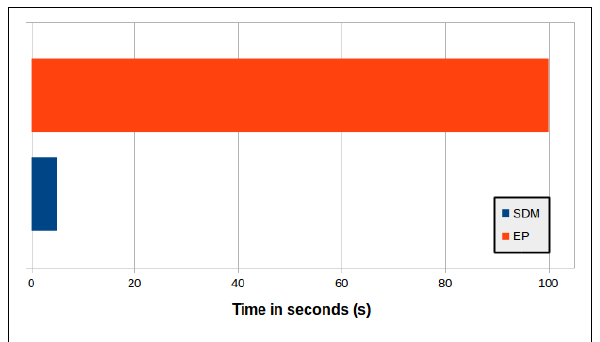
Figure 10. Average Mitigation Time: SDM vs